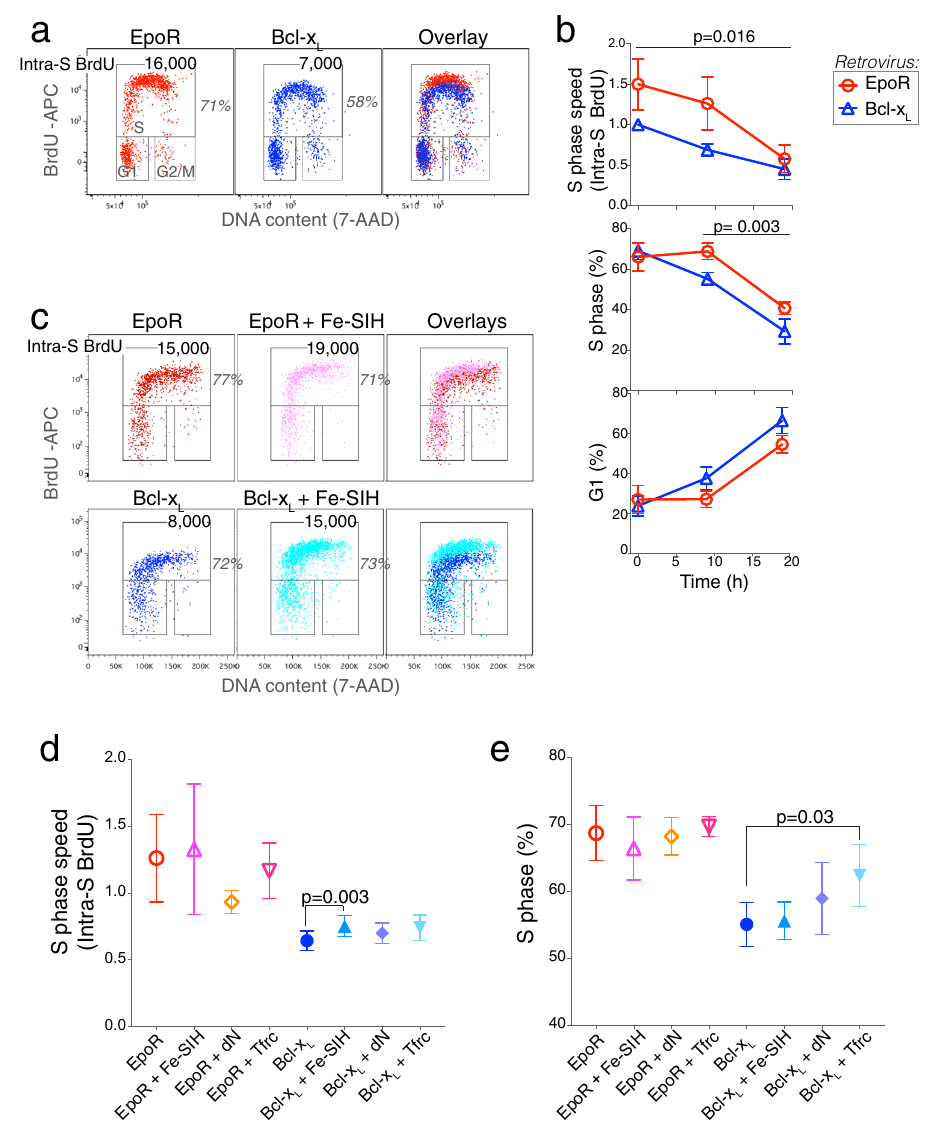
Fig. 3 EpoR regulates the speed of S phase. a Cell-cycle analysis of Epor − / − fetal liver cells transduced with either EpoR or Bcl-x L and cultured as in Supplementary Fig. 2b. Cells were pulsed with BrdU for 30 min at t = 9 h and were immediately harvested for analysis. The fraction (%) of erythroblasts (hCD4 + Lin − ) in S phase is indicated, as is S phase speed, measured as the intra-S phase rate of BrdU incorporation (BrdU MFI within the S phase gate). b Summary of cell-cycle status and S phase speed, as measured by intra-S phase BrdU incorporation in EpoR or Bcl-x L -transduced Epor − / − fetal liver cells. Data is pooled from 6 independent experiments similar to ( a ). In all cases, cells were pulsed with BrdU for 30 min prior to harvesting for analysis. Data are mean ± sem. Intra-S phase BrdU (MFI) is expressed as the ratio to BrdU MFI of Bcl-x L -transduced fetal liver cells at t = 0 in each experiment. Signi fi cance p -values are two-tailed paired t test, pairing EpoR and Bcl-x t = 9 and L -transduced cells for each time point across all experiments (upper panel), and for t = 19 h in all experiments (middle and lower panels). c Effect of the cell-permeable iron carrier, Fe-SIH (10 μ M) on S phase speed. Experiment and cell- cycle analysis as in ( b ). Cells were harvested at t = 9 h. d , e Summary of S phase speed ( d ) and cell-cycle status ( e ) in EpoR and Bcl-x L -transduced Epor − / − fetal liver cells at t = 9 h, experimental design as in Fig. 2b, and ( a ) to ( c ) above. S phase speed is expressed relative to the speed at t = 0 in each experiment. Shown are the effects of adding Fe-SIH or dN to the medium, or of doubly transducing cells with both Bcl-x L and Tfrc. Data are mean ± sem for n = 4 independent experiments each for Fe-SIH and dN, and n = 3 for Tfrc . All experiments also had Epor − / − fetal liver cells transduced with EpoR and with Bcl-x L without additional additives or transductions. P -value is for a two-sided t test, unequal did not rescue the smaller size of Bcl-x L - Epor − / − erythroblasts (Fig. 4b), it remained possible that intracellular iron delivery was somehow incomplete. To determine de fi nitively the relevance of the iron/heme/ HRI pathway to cell size regulation by EpoR, we generated Epor − / − Hri − / − mice (Fig. 5a). Similar to Epor − / − mice, Epor − / − Hri − / − mice died at mid-gestation with severe anemia. We rescued both Epor − / − and Epor − / − Hri − / − -fetal liver cells